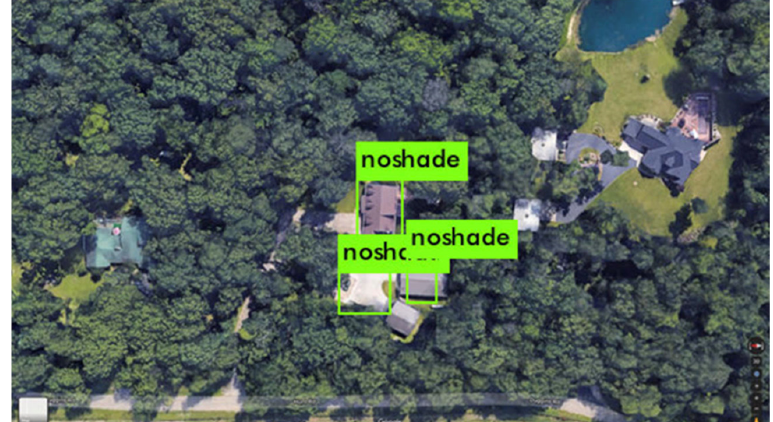
Figure 7. The testing data .